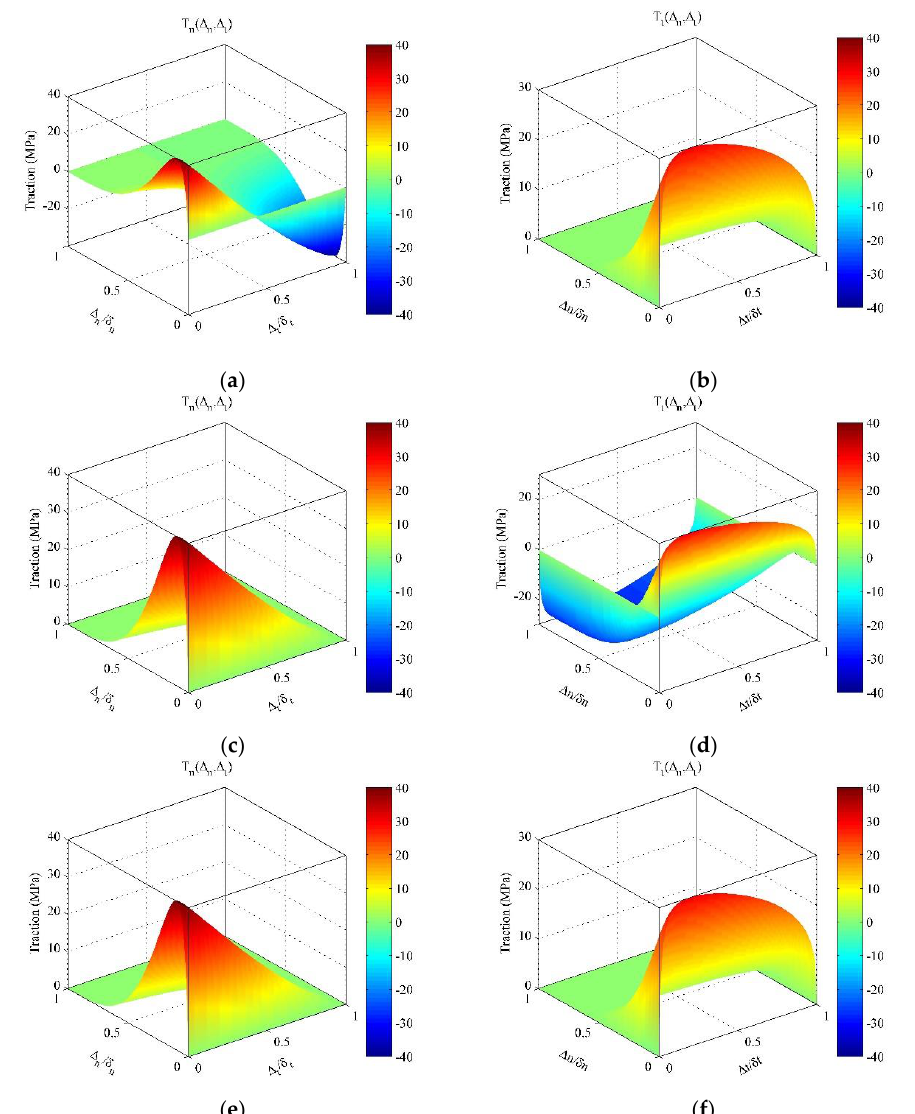
Figure 2. The cohesive tractions with 𝜙 𝑛 = 100 N/m and 𝜙 𝑡 = 200 N/m ( a , b ); or 𝜙 𝑛 = 200 N/m and 𝜙 𝑡 = 100 N/m ( c , d ); 𝜙 𝑛 = 200 N/m and 𝜙 𝑡 = 200 N/m ( e , f ). Normal traction ( a,c,e ); tangential traction ( b,d,f ).